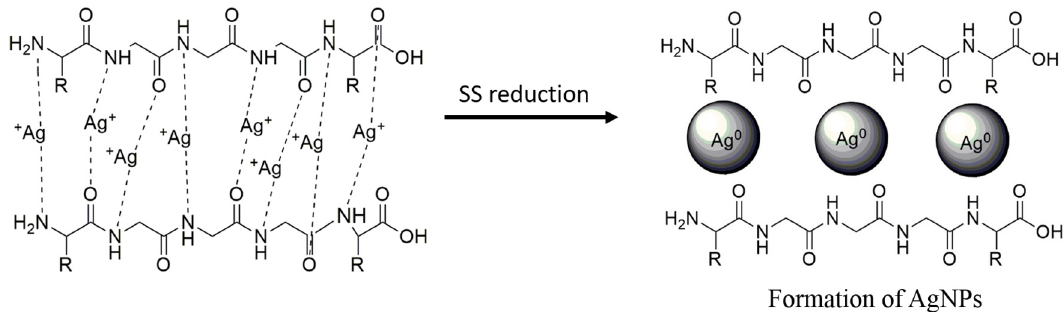
Figure 3. Schematic mechanism of the in situ synthesis of SS ‐ Ag nanocomposite.